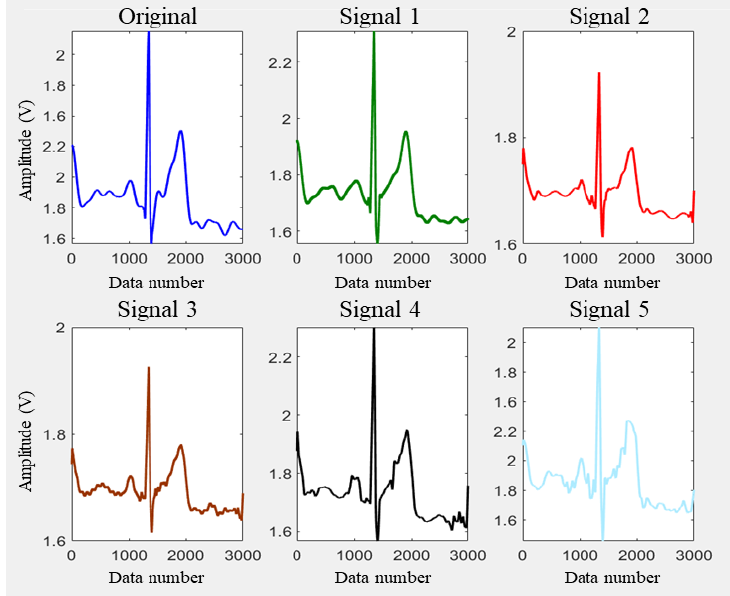
Figure 4. ECG signals generated by the matching pursuit algorithm. The matching pursuit algo- rithm generates a correlation matrix obtained through the inner product and selects values in the order such that the correlation size is the largest. The matching pursuit algorithm uses this value to output similar signals.